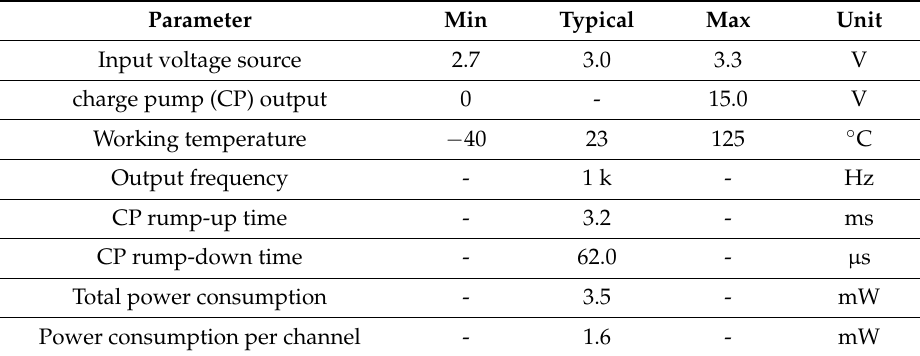
Table 3. Some testing parameters and results of the designed 2-channel LC driver